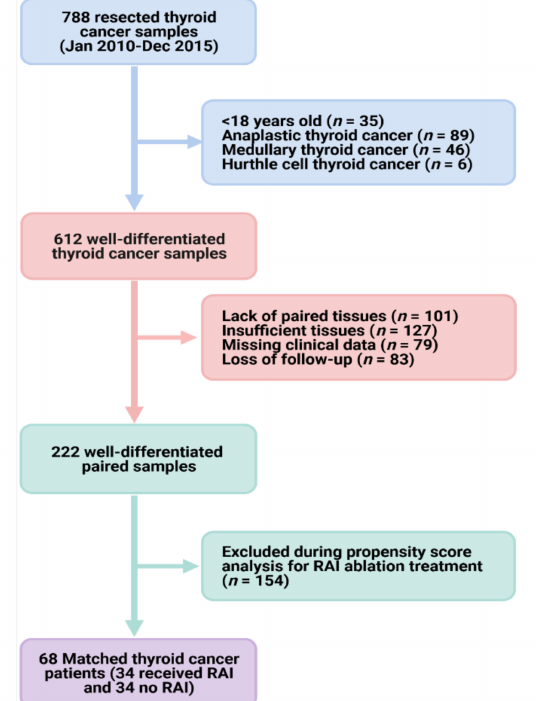
Figure 1. Workflow for patient selection. ATA: American Thyroid Association. We reviewed 788 thyroid cancer samples for patients who underwent subtotal/total thyroidectomy for papillary or follicular thyroid carcinoma. Histopathological analysis was performed, and samples with insufficient tissue available for molecular work or lack of paired non-cancer tissues were excluded. After accounting for selection bias through propensity score analysis, two groups were established with similar general baseline features: (1) 34 paired cancer and non-cancer tissues for patients who underwent thyroidectomy and (2) another 34 paired tissues for those who received RAI following tumor